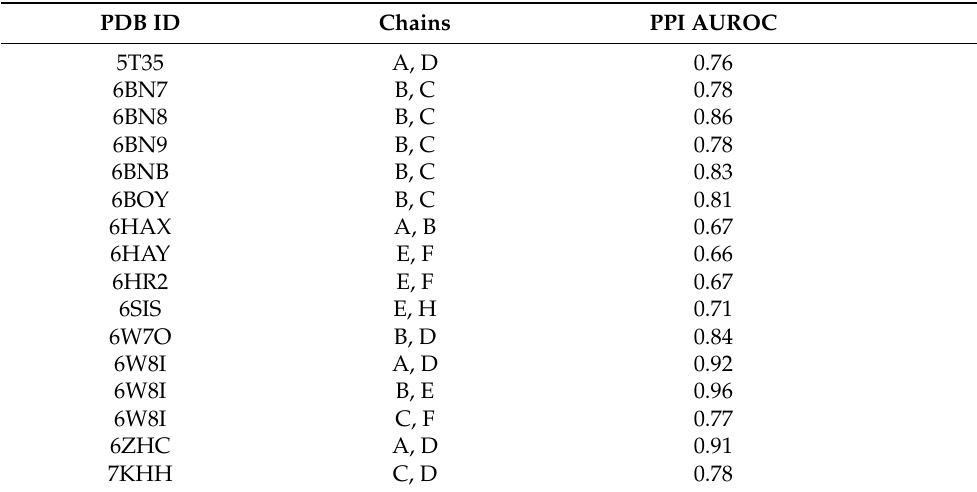
Table A6. AUROC scores for PPI prediction of our model trained on the orthogonal dataset (see Figure 4, panel B).